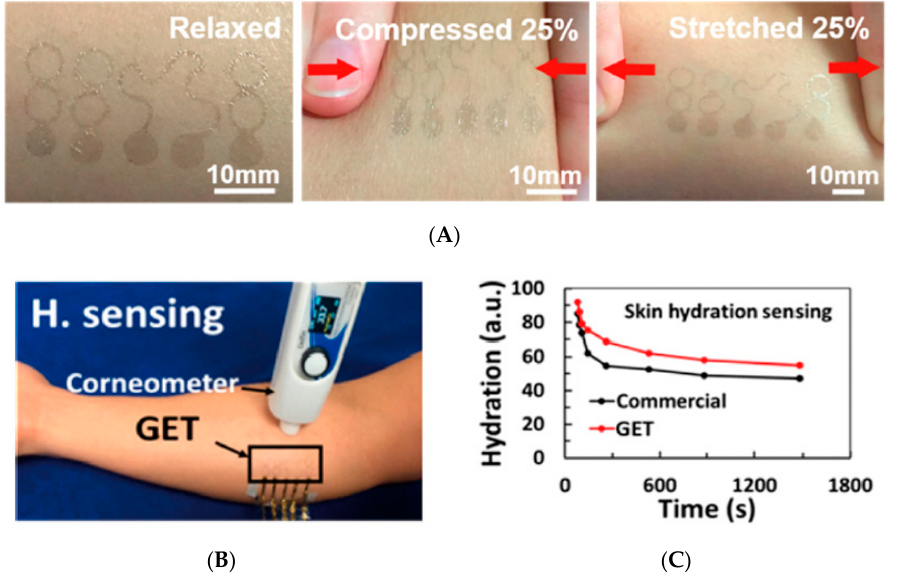
Figure 22. ( A ) Graphene based electronic tattoo mounted on skin. ( B ) Demonstration of the graphene electronic tattoo (GET) sensor as skin hydration sensor, compared to a commercial corneometer. ( C ) Skin hydration after application of body lotion, using the humidity sensor of the GET and the commercial corneometer. Reproduced from [69] with permission. Copyright © 2017, American Chemical Society.